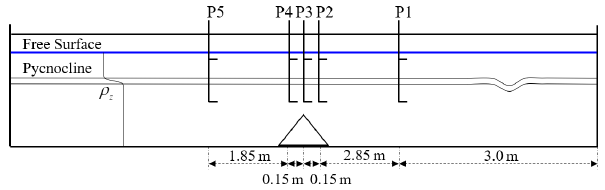
Figure 9. Schematic illustration of the laboratory set-up and the locations of the probes (Hsieh et al., 2015).